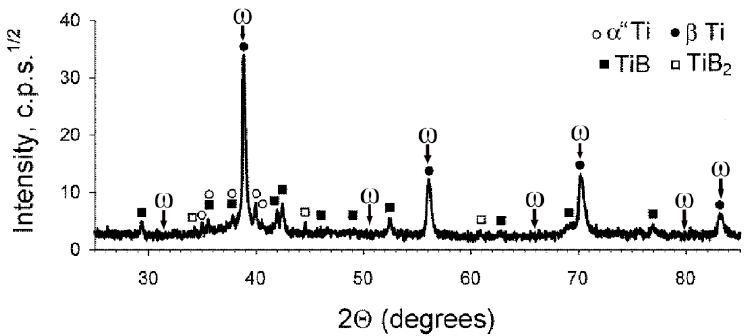
Figure 3. XRD patterns of Ti-15Mo/TiB metal matrix composite.